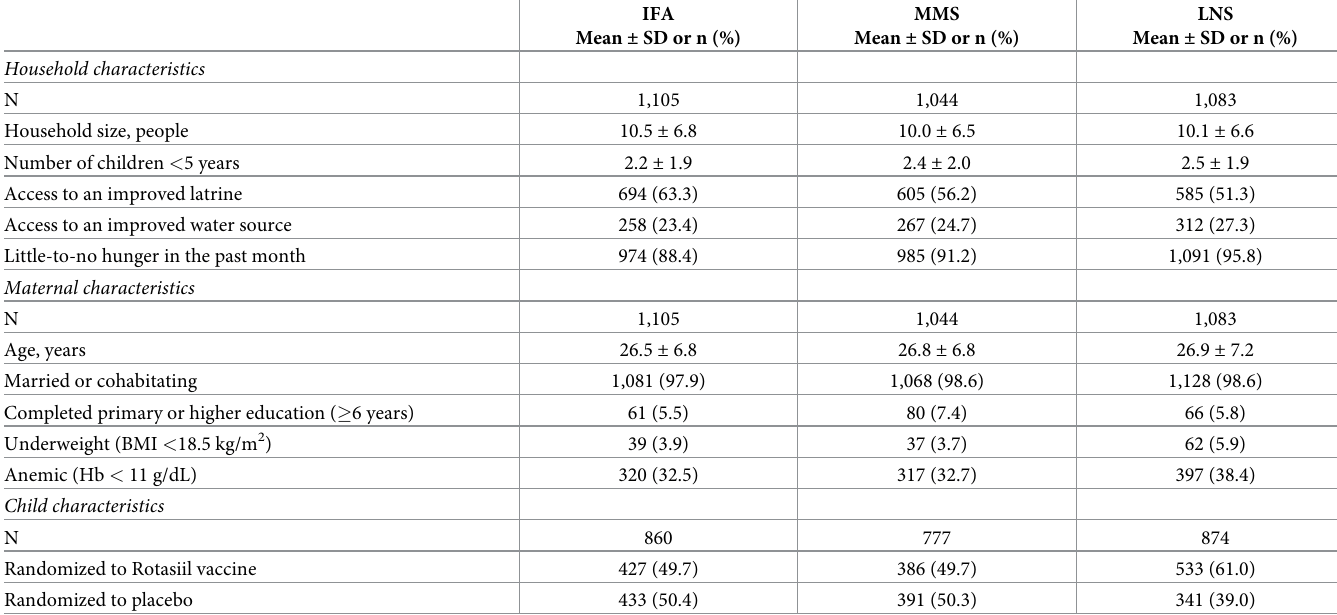
Table 1. Characteristics of pregnant women and children by randomized